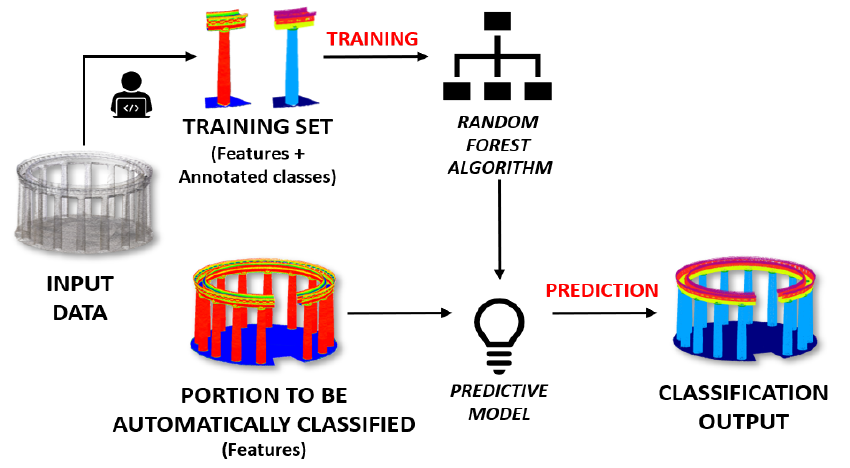
Figure 1. Three-dimensional (3D) point cloud classification process where a portion of the dataset is used as training set.